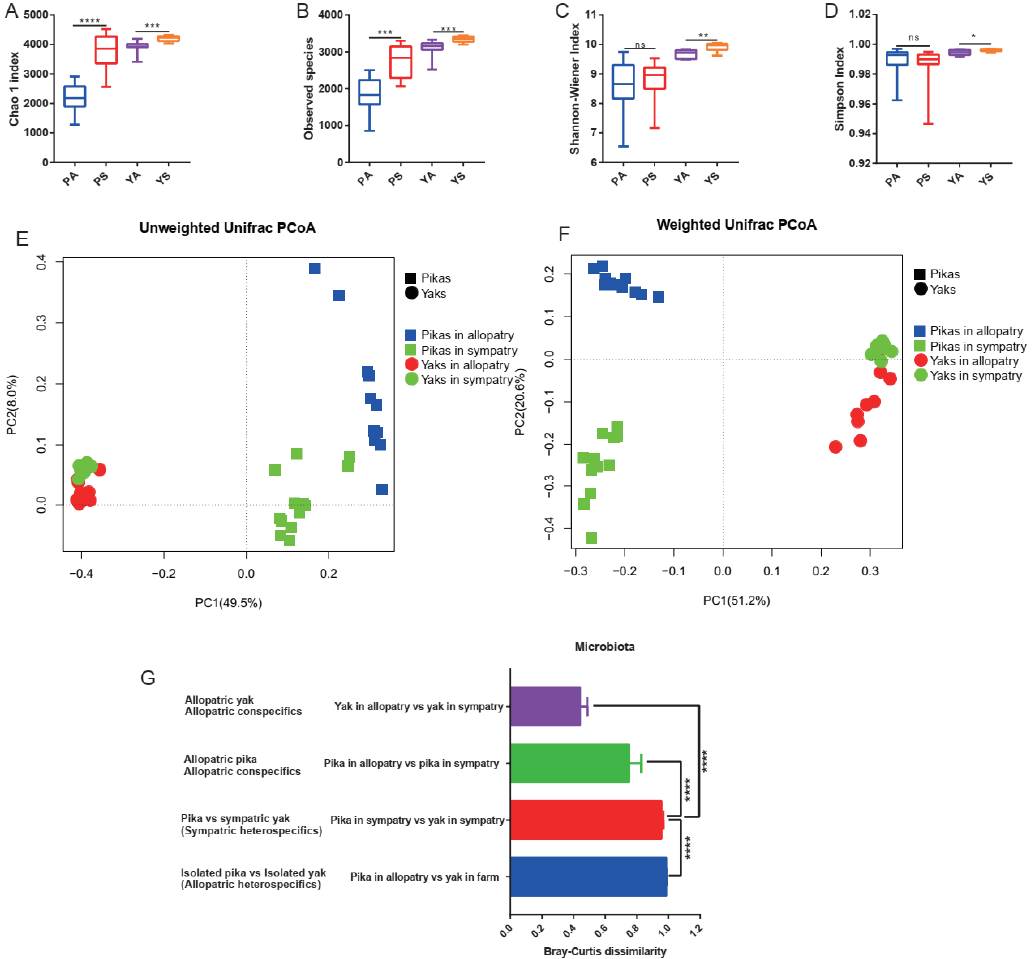
Figure 4. ( A ) The Chao1 index with comparison between allopatric groups and sympatric groups. The “PA”: the pikas in the allopatric enclosure, “PS”: sympatric pikas with yaks, “YS”: sympatric yaks with pikas, and “YA”: yaks in allopatric farms. ( B ) The observed species number with comparison between allopatric groups and sympatric groups. ( C ) The Shannon diversity index with comparison between allopatric groups and sympatric groups. ( D ) The Simpson index with comparison between allopatric groups and sympatric groups. ( E ) Unweighted UniFrac distance across allopatric individuals and sympatric individuals. ( F ) Weighted UniFrac distance across allopatric individuals and sympatric individuals. ( G ) Bray–Curtis dissimilarities with comparison among sympatric congenerics, allopatric congenerics, sympatric heterogenerics, and allopatric congenerics.